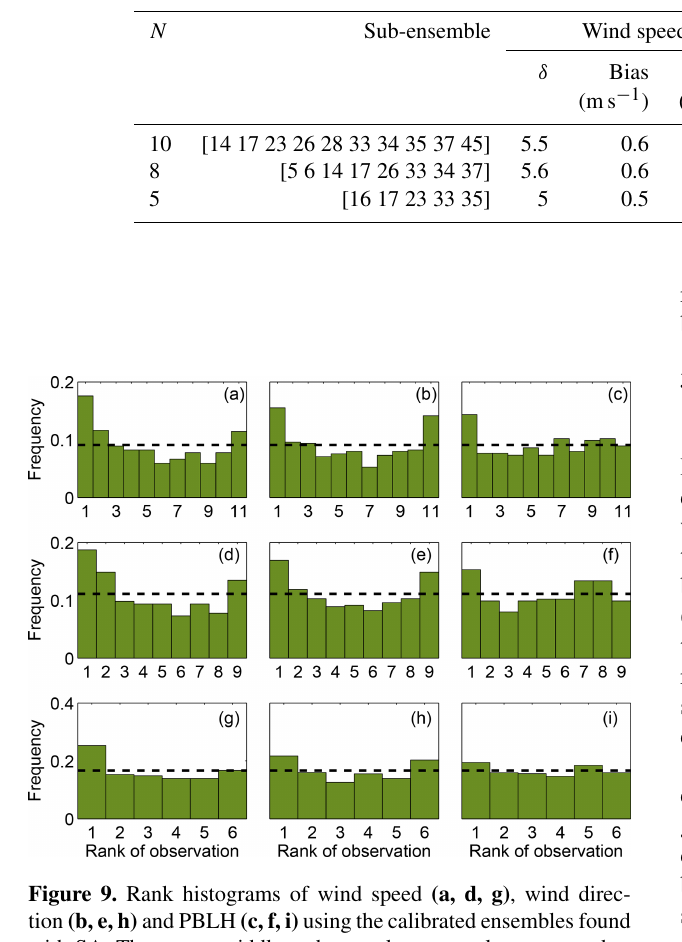
Table 4. Ensemble members, rank-histogram scores ( δ ), bias and standard deviation ( σ ) for wind speed, wind direction and PBLH for the calibrated sub-ensembles generated with SA.